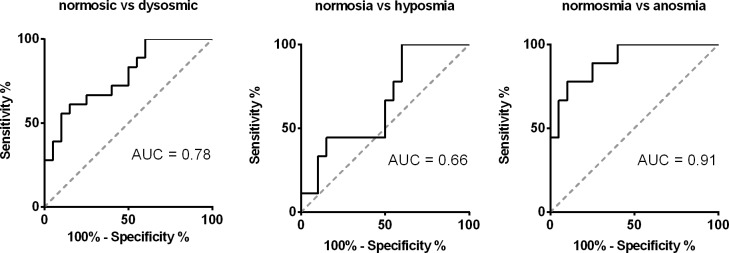
Distinguishing between patients and normosmic participants by means of time-frequency analysis.Displayed are the AUC calculated by ROC analysis to distinguish between normosmic participants and dysosmic (hyposmic/anosmic) patients. The analysis revealed an AUC of 0.78 for the separation of normosmic participants and dysosmic patients. The analysis between normosmic participants and anosmic patients was even greater with an AUC of 0.91.